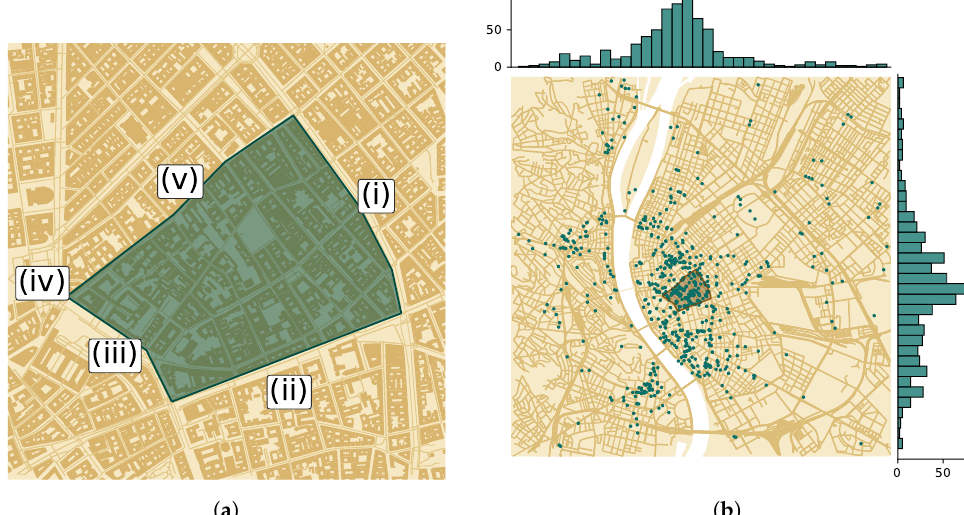
Figure A1. The borders of the party district ( a ), within District 7; and bars, pubs, beer gardens and nightclubs in Budapest downtown ( b ), based on OpenStreetMap